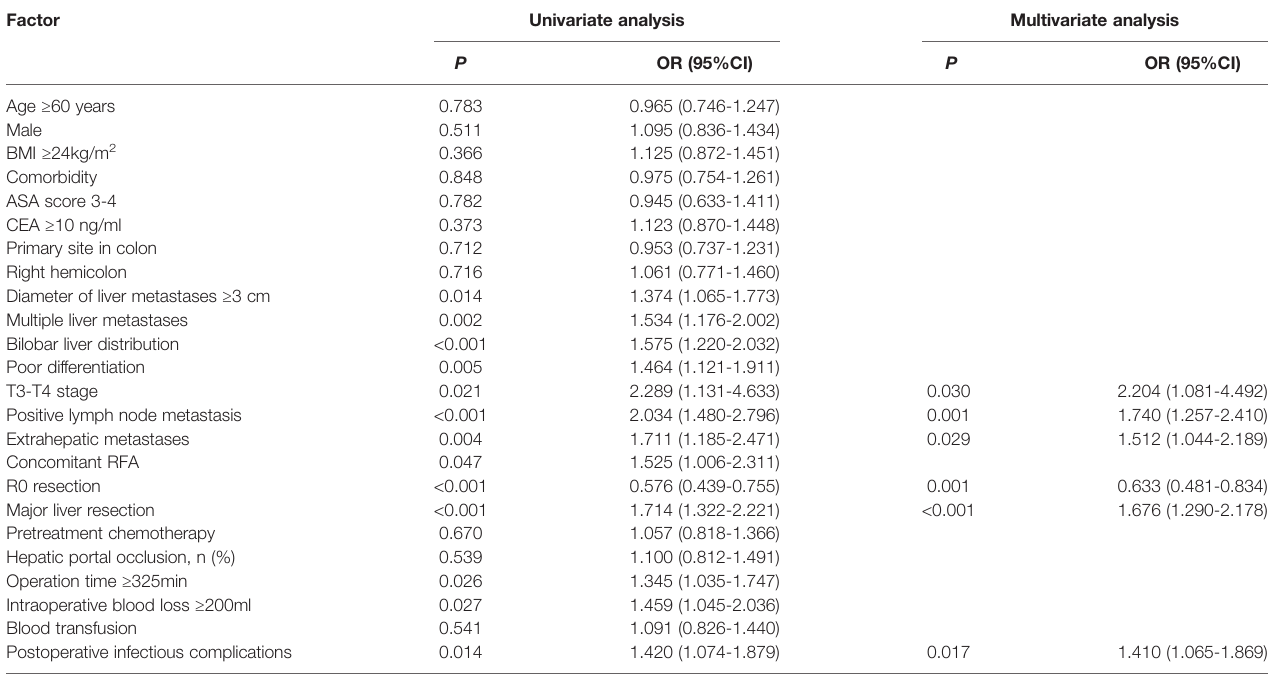
TABLE 6 | Prognostic factors for PFS in CRLM patients after PSM.